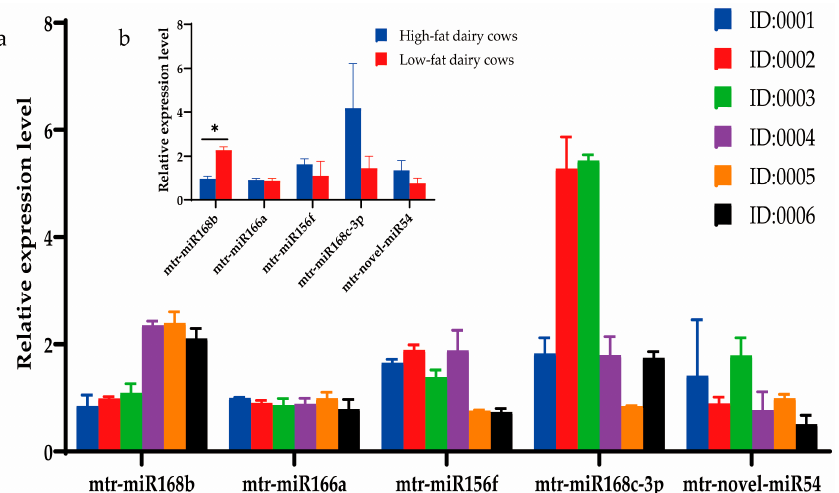
Figure 3. Relative expression of alfalfa miRNAs in milk as determined using qRT-PCR. Data are given as the mean ± SD for n = 3/group. * p < 0.05 was considered statistically significant. ( a ) miRNA expression levels in milk and ( b ) significant difference in miRNAs between high-fat-milk and low-fat-milk dairy cows.